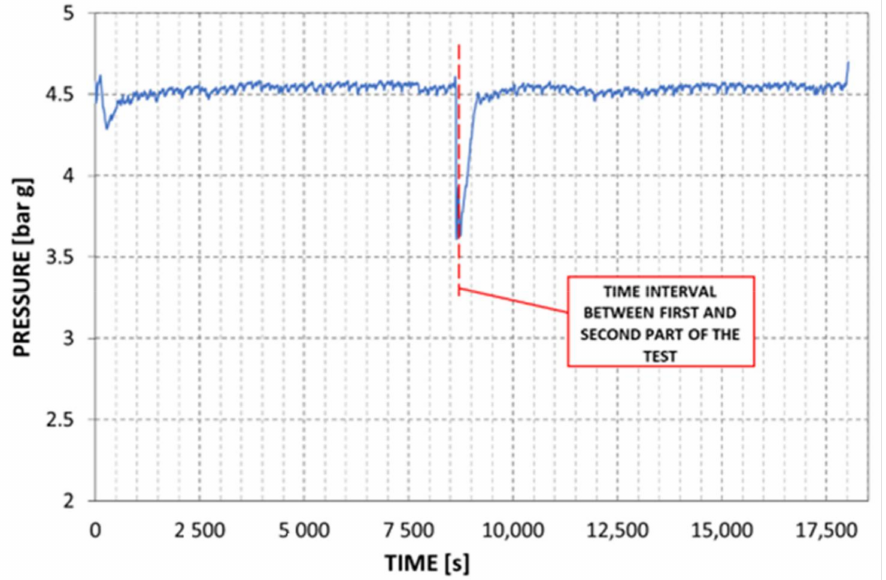
Figure 8. Plot over time of the hydrogen pressure in the low-pressure buffer during the test with hydrogen compressor running at 44 cycles per minute.